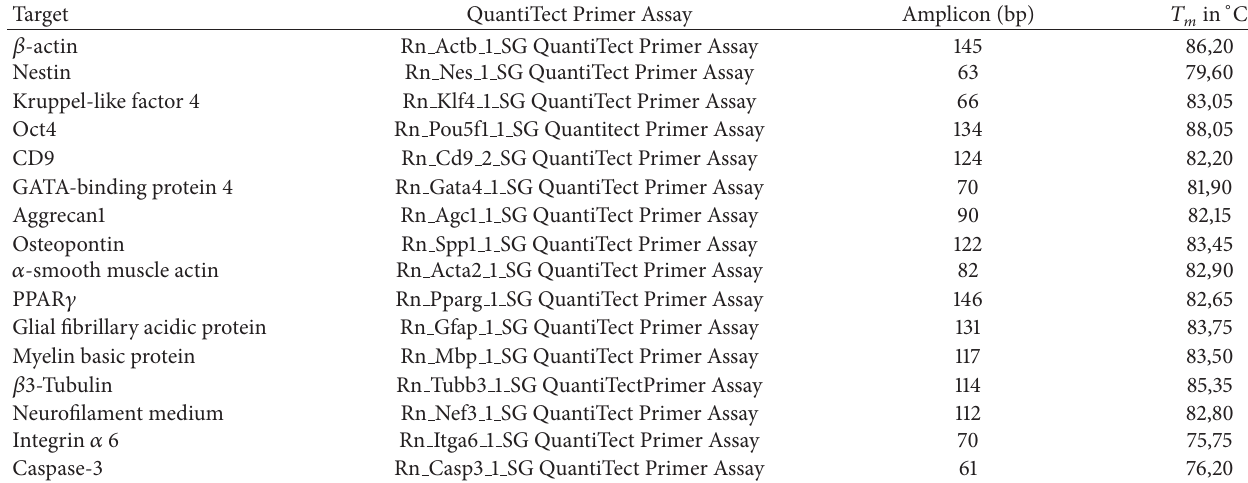
Table 1: List of the used QuantiTect Primer Assays commercially available from